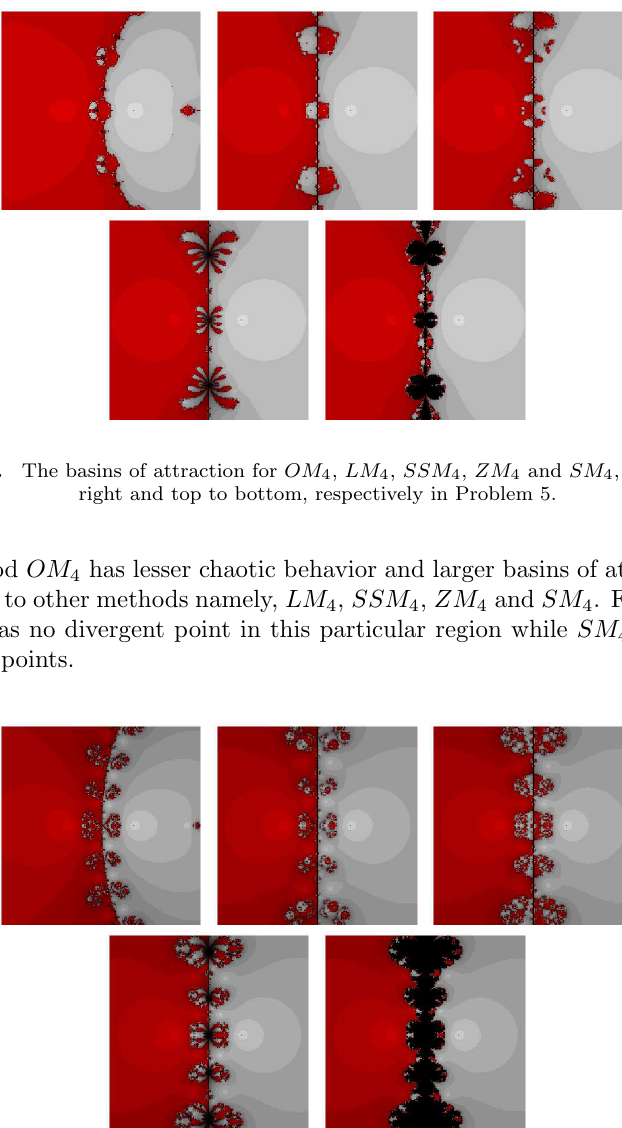
Figure 9. The basins of attraction for OM 4 , LM 4 , SSM 4 , ZM 4 and SM 4 , from left to right and top to bottom, respectively in Problem 6.